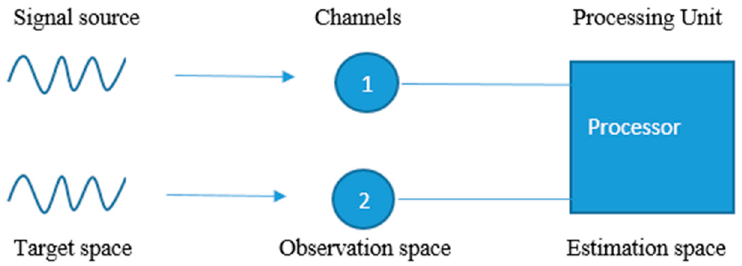
Figure 3. Structure of DOA estimation.